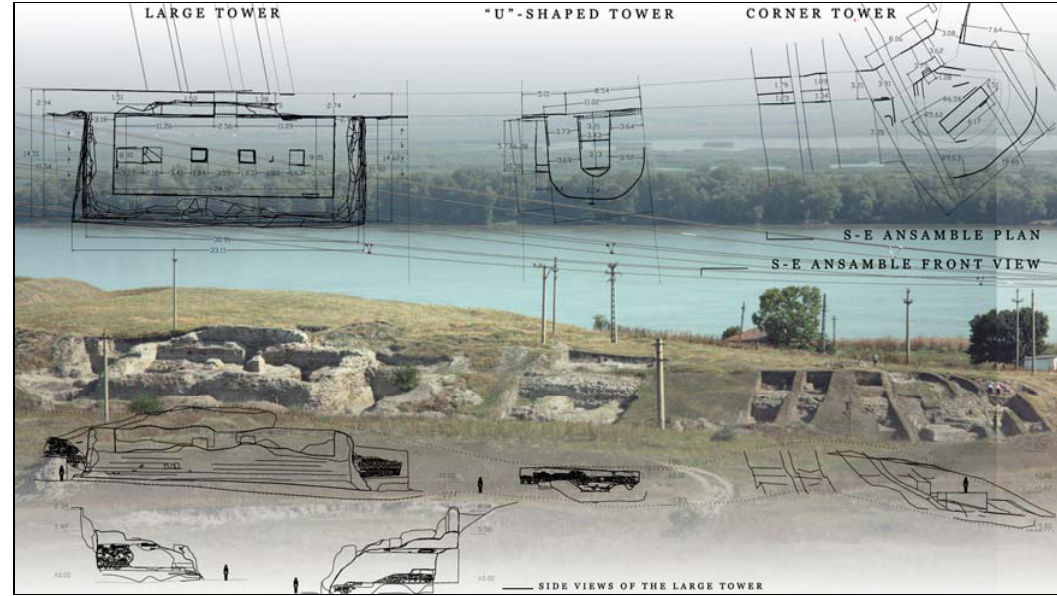
Figure 10. 2D architectural drawings made in AutoCAD for the three towers, overlapped on a